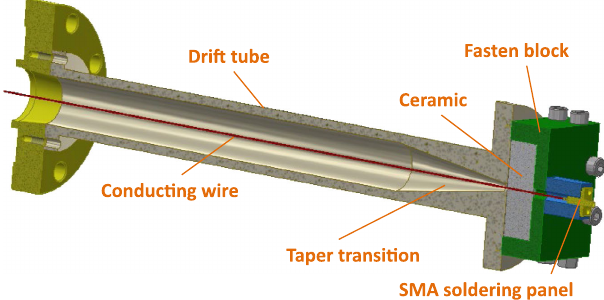
FIG. 10. The CAD drawing of the matching section and mounting of the wire with the ceramic fasten block.